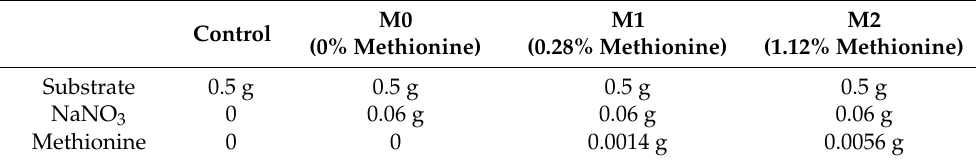
Table 2. Quantity of substrate and treatment used in each in vitro